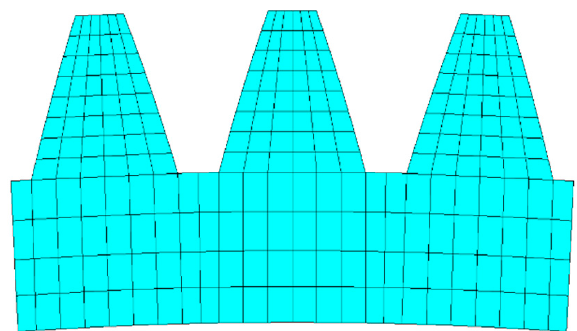
Figure 4. Simplified mesh model of the flexible wheel profile.